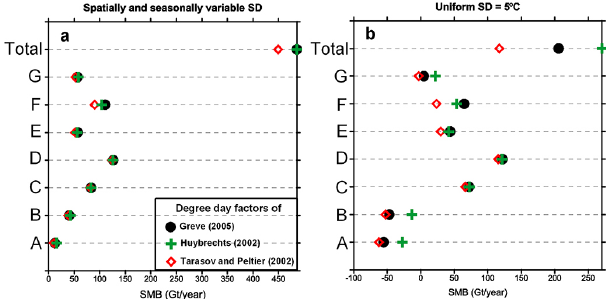
Fig. 6. Sensitivity of the modeled regional and total SMB to a selection of degree-day factors. Modeled SMB values are aver- aged over the reference period from 1958 to 2001 and over major drainage basins shown in Fig. 1. (a) shows the results of simulations with spatially and seasonally variable SD and degree-day factors of Greve (2005), Huybrechts (2002) and Tarasov and Peltier (2002) in contrast to the results of analogous simulations with the uniform SD value of 5 ◦ C shown in (b)